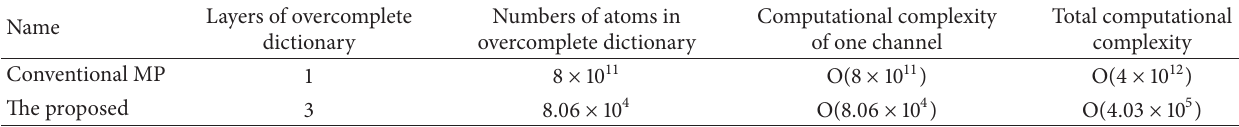
Table 3: Computational complexities of the proposed method and the conventional